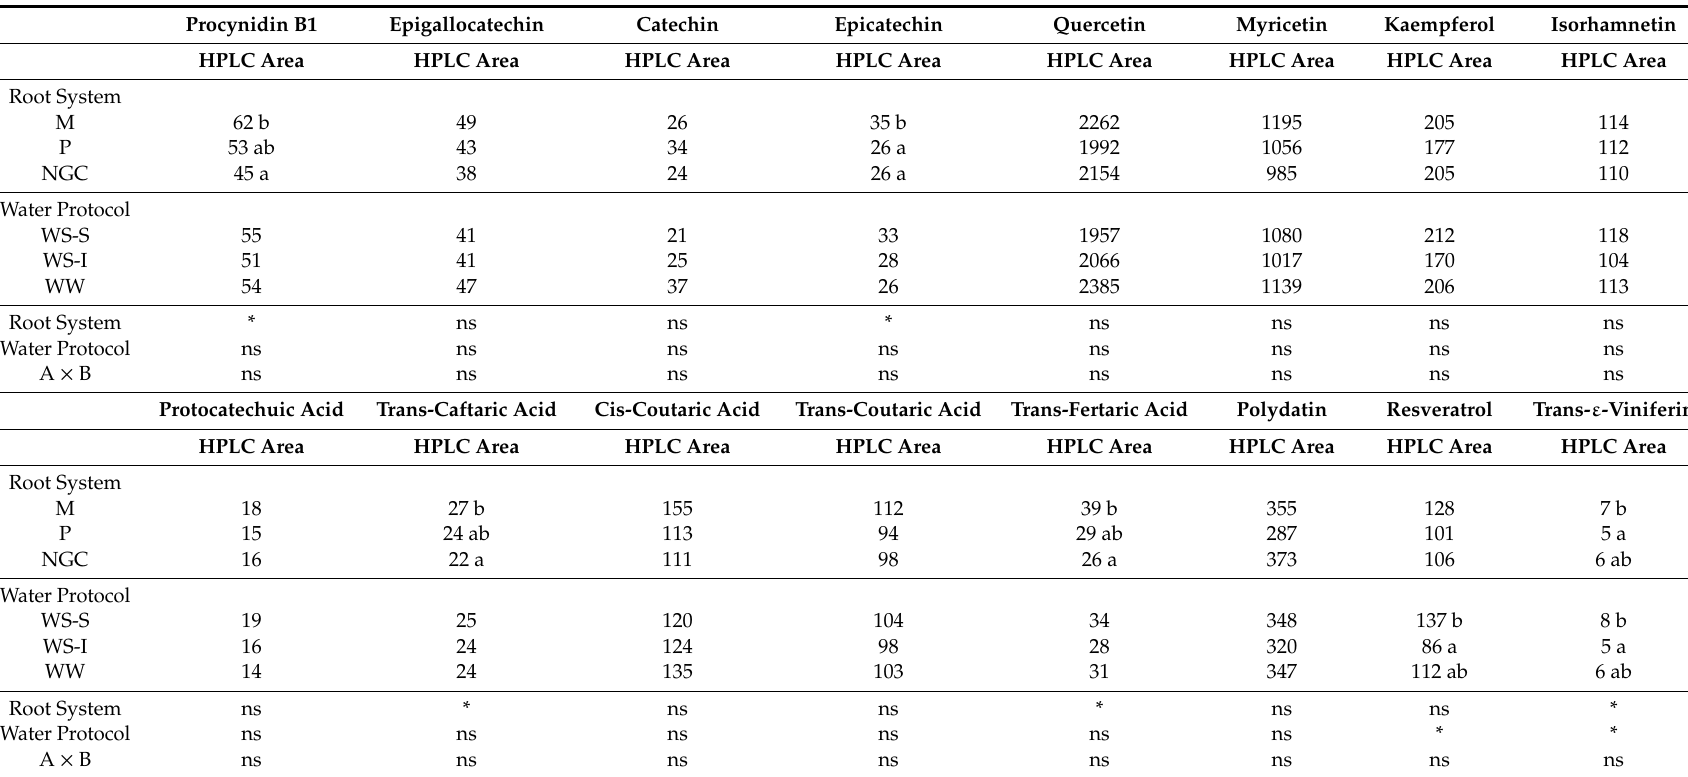
Table 4. Phenolic compounds detected by HPLC in berry skins of Pinot noir vines grafted on Mgt 101-14 (M), 1103 Paulsen (P), and not grafted vines (NGC), treated with three irrigations protocols (WS-S, WS-I, and WW). Data were subjected to two-way ANOVA: *, ns indicate significant di ff erences at P < 0.05, or not